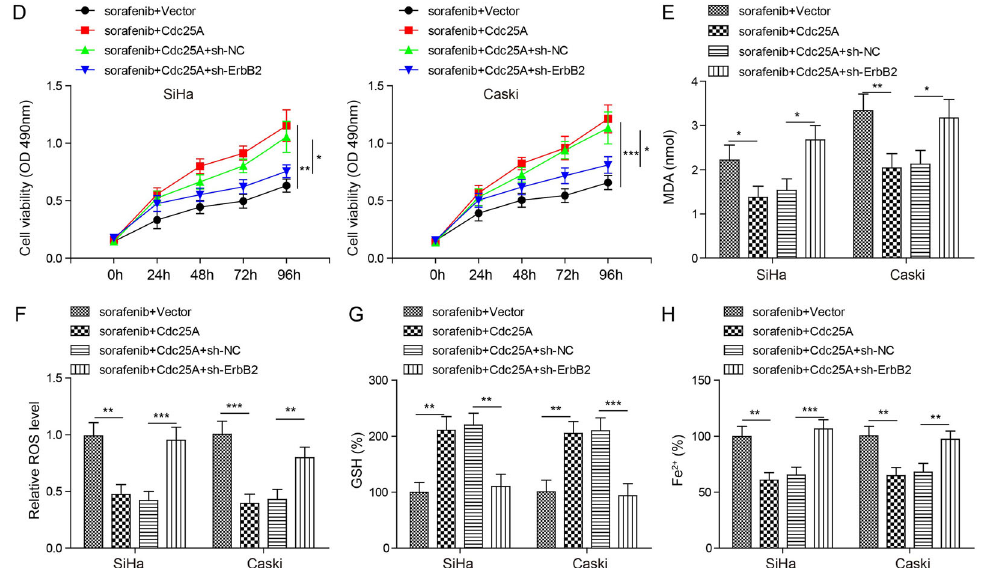
Fig. 7 Cdc25A regulated sorafenib-induced ferroptosis via ErbB2. A Relative ErbB2 mRNA levels in transfected cells with or without sorafenib treatment. B Relative protein levels of ErbB2, p62, LC3-I, and LC3-II in transfected cells with or without sorafenib treatment. C Relative GFP-LC3 signalling in transfected cells following sorafenib treatment. D The MTT assay to analyse the viability of transfected cells following sorafenib treatment. E Cellular MDA levels in transfected cells after sorafenib treatment. F Cellular ROS levels in transfected cells after sorafenib treatment. G Cellular GSH levels in transfected cells after sorafenib treatment. H Cellular iron levels in transfected cells after sorafenib treatment. Each experiment was repeated three times. * P < 0.05; ** P < 0.01; *** P <